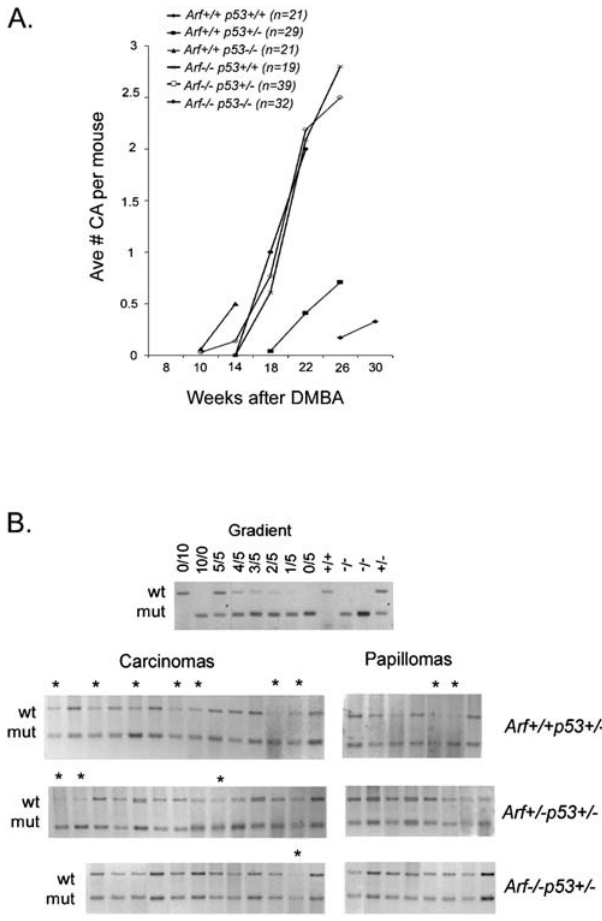
Figure 6. Tumor Progression and p53 LOH in p19 Arf /p53 Compound Mutant Mice (A) Average number of carcinomas per mouse is plotted against the number of weeks postinitiation. Tumor progression was accelerated in all p19 Arf (Arf)- and p53 -deficient genotypes compared to wild-type littermates . Carcinoma latency and multiplicity was almost identical for p19 Arf (cid:1) / (cid:1) mice regardless of p53 genotype ( p53 þ / þ , p53 þ / (cid:1) , or p53 (cid:1) / (cid:1) ). (B) LOH of the wild-type p53 allele by semiquantitative PCR in p19 Arf /p53 compound tumors. Gradient made from kidney DNA used for quantitation of wt/mu ratio (top row). wt, wild-type allele; mu, knockout allele; asterisk, tumors with reduction of wild-type p53. DOI: 10.1371/journal.pbio.0020242.g006